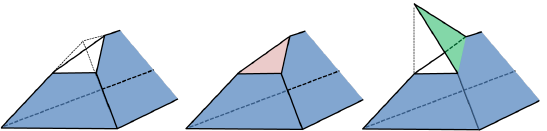
Figure 7. Simulation of an uncovered detail – left: the blue ob- ject is reconstructed, but the upper front part is missing. Adding an area of the uncovered detail leads to two possibilities. Either